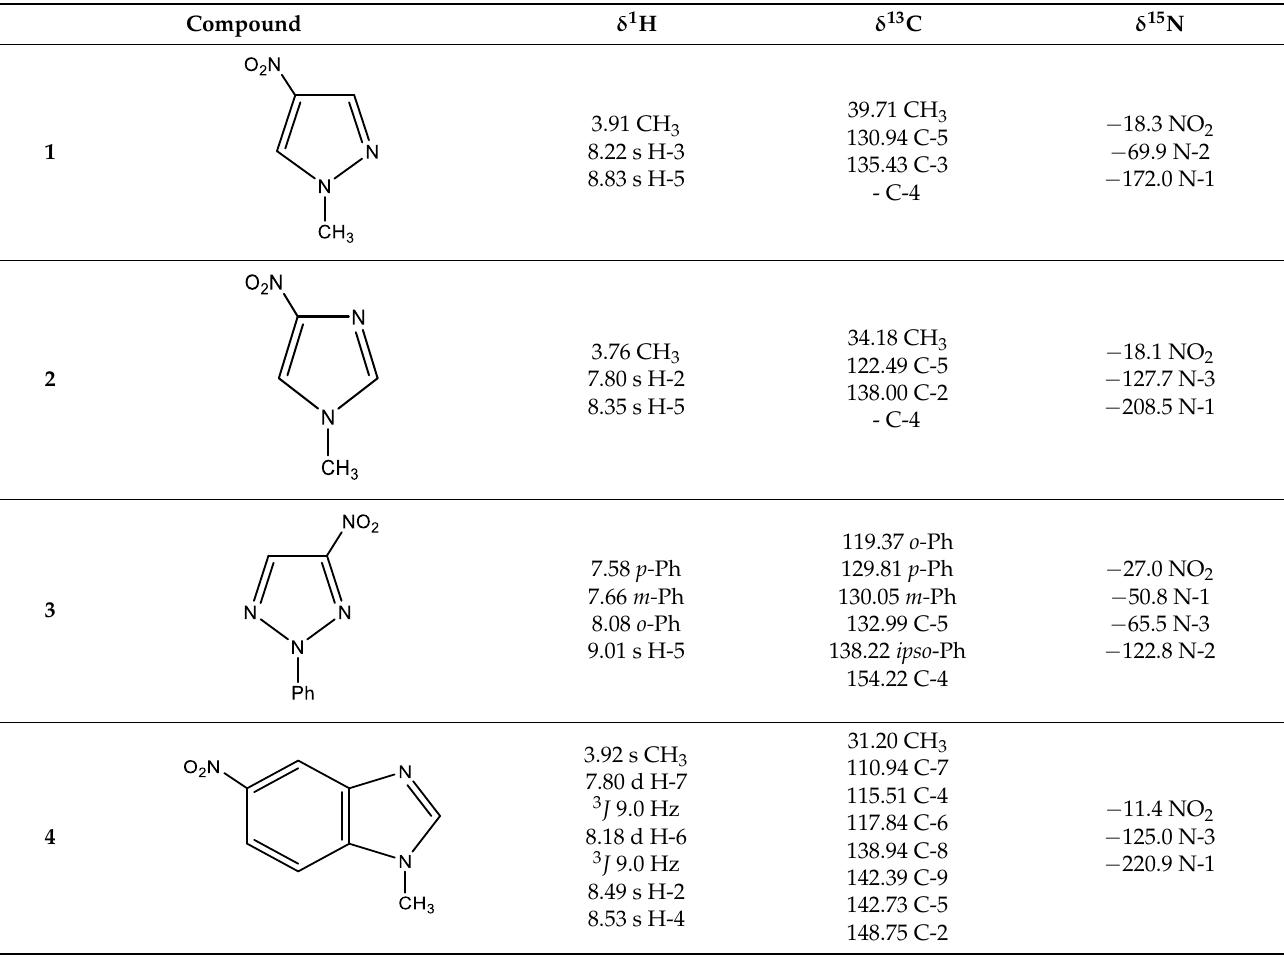
Table 1. 1 H, 13 C and 15 N NMR chemical shifts of nitroazoles and their aminated products (ppm) (DMSO- d 6 ).